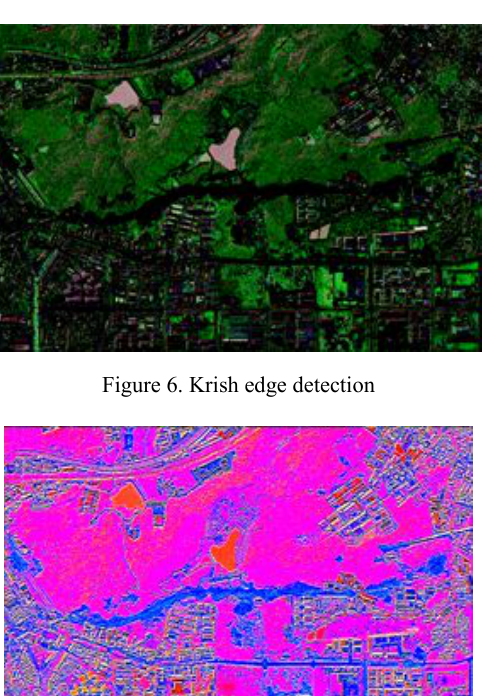
Figure 5. Prewitt edge detection